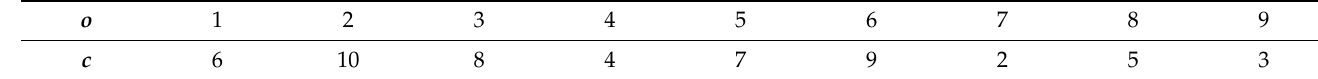
Table 3. Disassembly costs of different types of tools.